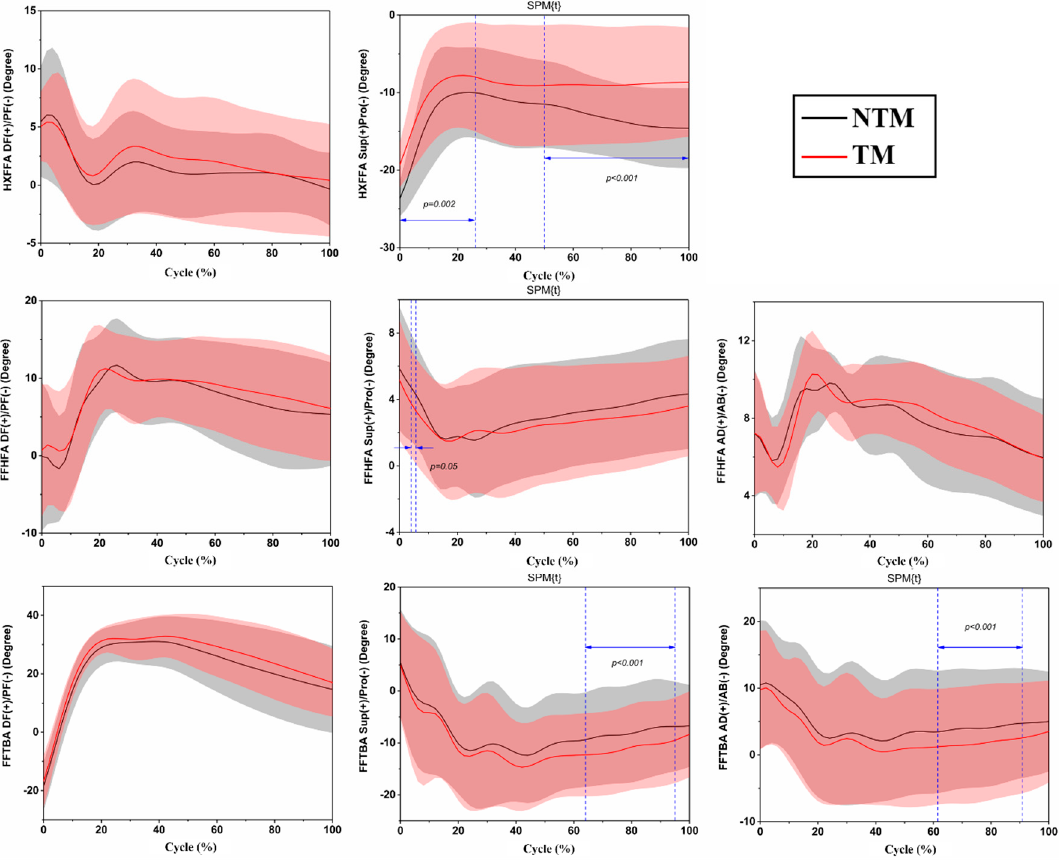
Figure 3. The foot inter-segment angle di ff erences during landing in Non-Toe-Manipulation ( NTM ) and Toe-Manipulation ( TM ) sessions. Blue lines highlight areas that indicate significant di ff erences according to spm1d with p < 0.05. Abbreviations: DF: dorsiflexion, PF: plantarflexion, Sup: supination, Pro: pronation, AD: adduction, AB: abduction, Inv: inversion, Ev: eversion, Int.: internal rotation, Ext.: external rotation.